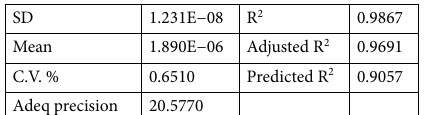
Table 8. Fit statistics for the proposed model for high permeability region.